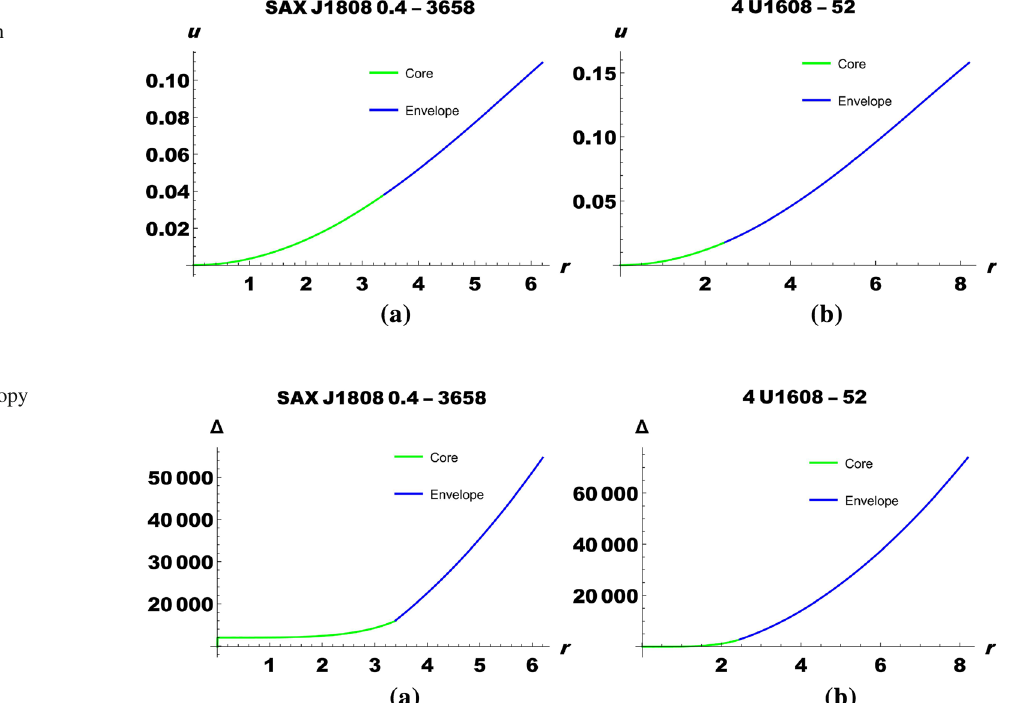
Fig. 7 Variation of compactification factor with radial coordinate